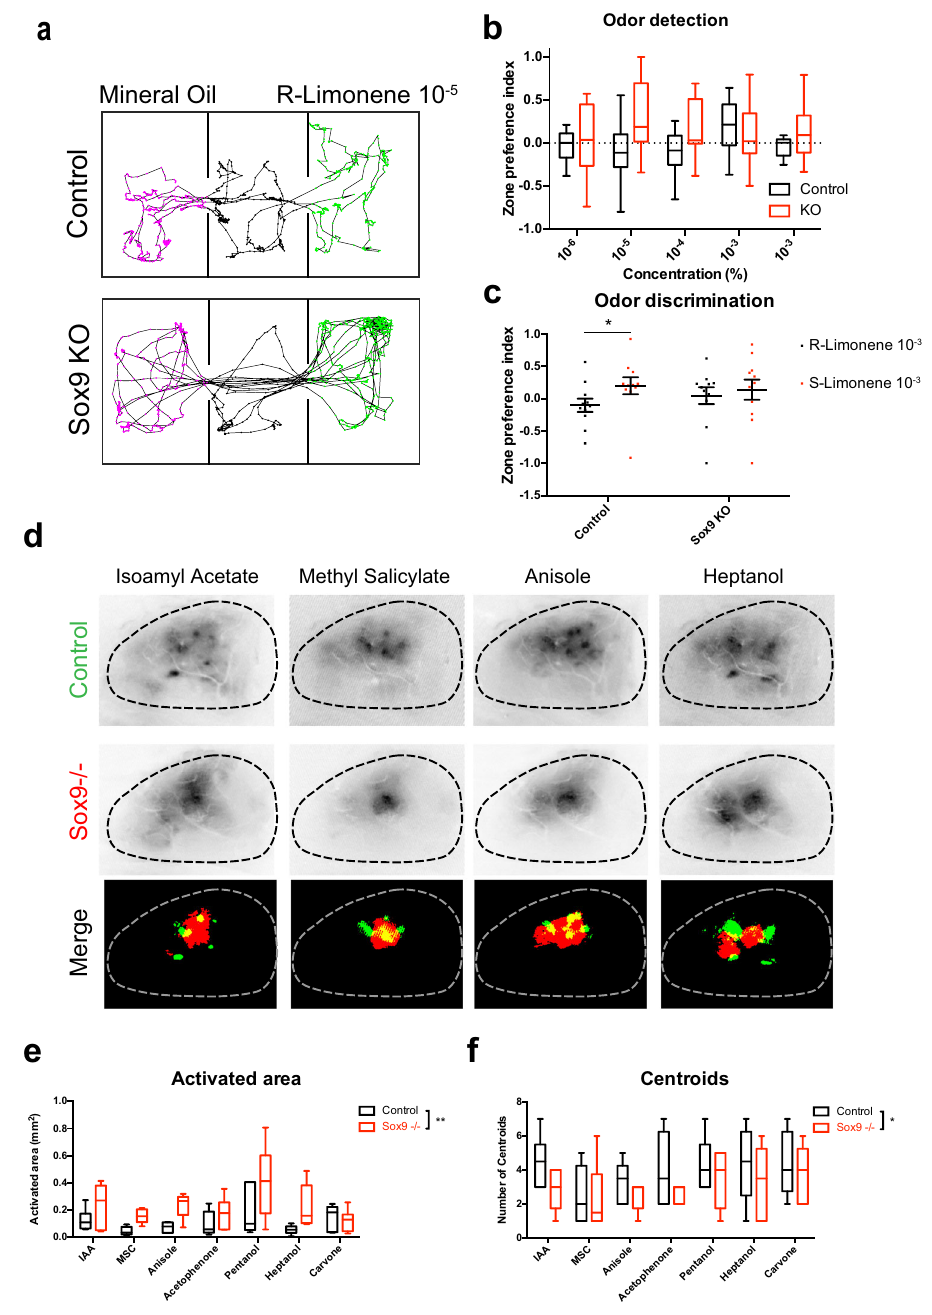
Fig. 3 Deletion of the astrocyte speci fi c marker Sox9 dysregulated olfactory behaviors and sensory maps. a Schematics of live mouse tracking during three compartment place preference assay. Top represents a control mouse investigating the both chambers equally with the odor present at 10 − 5 . Bottom represents a Sox9 KO mouse preferentially investigating the odor chamber at 10 − 5 . b Quanti fi cation of ( a ). n = 11 ( Sox9 KO) and n = 11 (Control). Two-way RM ANOVA with Bonferroni ’ s multiple comparison test (main effect of group, F(1,20) = 1.913, p = 0.1819; group X concentration interaction, F(3,60) = 3.385, p = 0.0238). Data are presented as box plots displaying interquartile range and median with Tukey whiskers. c Whisker plot quantifying three chamber place preference during odor discrimination. n = 11 ( Sox9 KO) and n = 11 (Control). Two-way RM ANOVA with Bonferroni ’ s multiple comparison test (main effect of odor, F(1,20) = 5.895, p = 0.0247; group X odor interaction, F(1,20) = 1.660, p = 0.2123). Data are shown as mean ± s.e.m. d Representative images of neuronal olfactory sensory maps from 4 different odorants of control animals vs astrocyte Sox9 KO animals. Merged image shows changes in olfactory sensory maps after binary thresholding. e , f Quanti fi cation of change in activated area (main effect of group, F(1,67) = 9.056, p = 0.0037) and number of centroids (main effect of group, F(1,70) = 6.235, p = 0.0149) in Sox9 KO animals vs controls. n = 6 mice per group. Two-way ANOVA with Sidak ’ s multiple comparison correction. Data are presented as box plots displaying interquartile range and median with Tukey whiskers. Control in A-C is C57BL/6 J injected with AAV-GFAP-iCre-P2a-TurboRFP; control in d – f is Thy1-GCaMP3 injected with